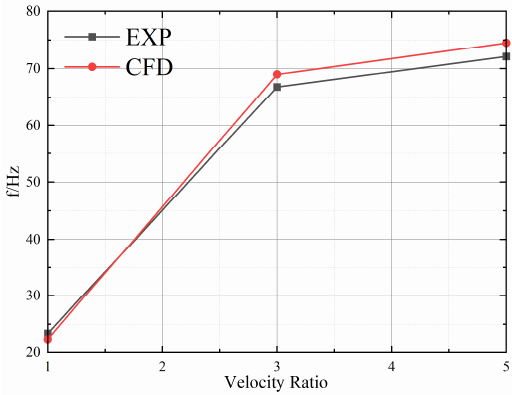
Figure 5. Sweep frequency at various velocity ratios.